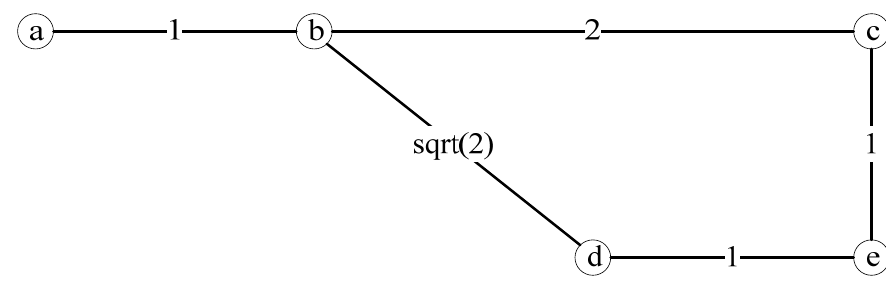
Figure 3. Schematic diagram of turning relationship transformation method.